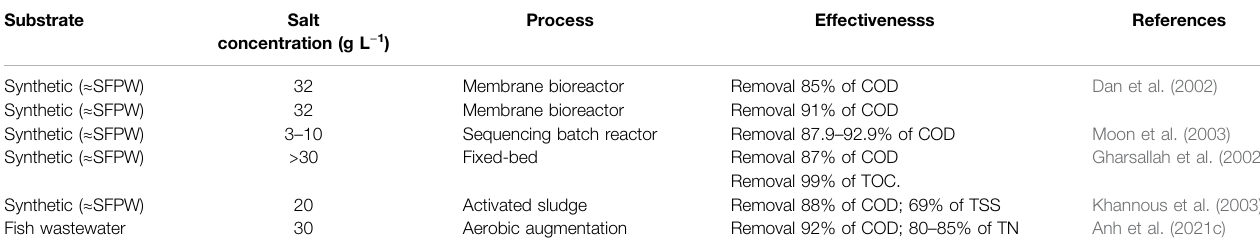
TABLE 3 | Examples of halophilic bacteria used in the aerobic treatment of saline wastewater.